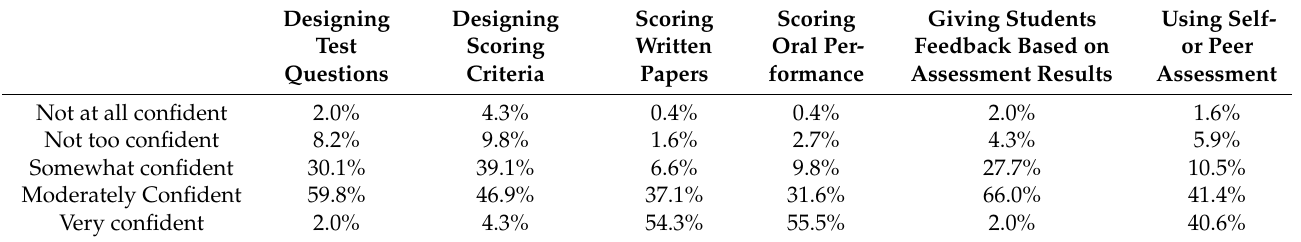
Table 5. The educators’ self-efficacy about their roles as